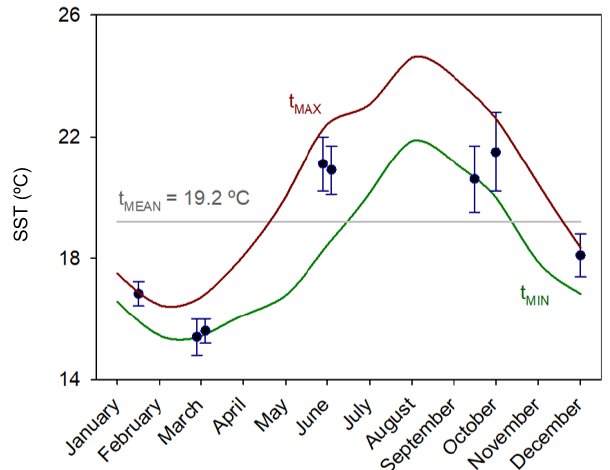
Figure 3. Maximum and minimum sea surface temperature (SST) variation during a 10-year period recorded by an oceanographic buoy located in the Gulf of Cádiz (36.48 ◦ N, 6.96 ◦ W). The red line shows maximum SST variation. The green line shows minimum SST variation. The grey line shows the average temperature for the 10-year period. Blue circles show mean values and standard devi- ations of underway SST measured during the eight cruises carried out during this study.